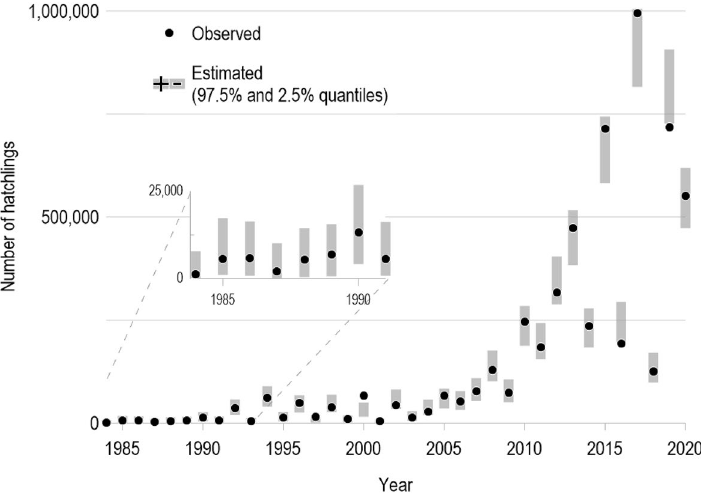
Figure 4. Observed number of hatchlings per year ( R ) of Chelonia mydas (black dots), with 95% prediction intervals constructed from fitting the extended Cushing model (Eq. (2)). The shaded regions outline 97.5% and 2.5% estimated quantiles of the positively-skewed distribution associated with hatchlings for a given sea surface temperature (from a 26-year cycle of the Atlantic Multidecadal Oscillation Index) and nesting females ( S ) for each year. This display shows that hatchling’s variance increases as its median (or mean) increases. The inset shows how the model fits the smallest values of the dataset.